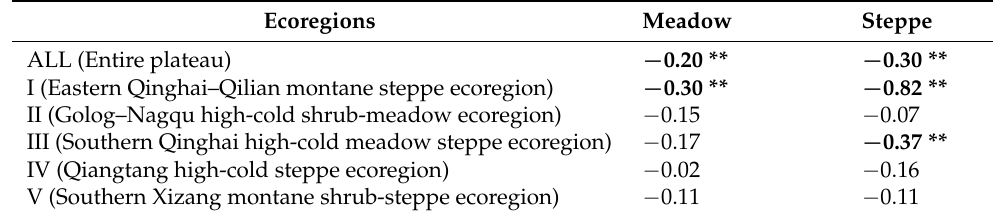
Table 1. Linear trends in multimethod averaged spring phenology (SOS) for steppe and meadow in different ecoregions from 2000–2017. Ecoregions Meadow Steppe ALL (Entire plateau) − 0.20 ** − 0.30 ** I (Eastern Qinghai–Qilian montane steppe ecoregion) − 0.30 ** − 0.82 ** II (Golog–Nagqu high-cold shrub-meadow ecoregion) − 0.15 − 0.07 III (Southern Qinghai high-cold meadow steppe ecoregion) − 0.17 − 0.37 ** IV (Qiangtang high-cold steppe ecoregion) − 0.02